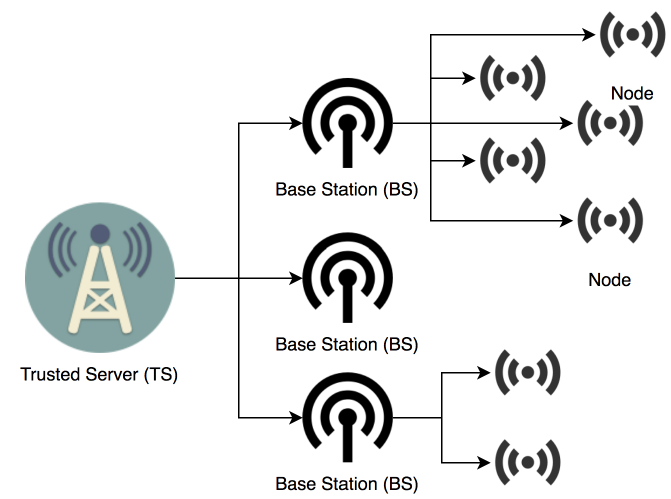
Figure 3. High level of network model in